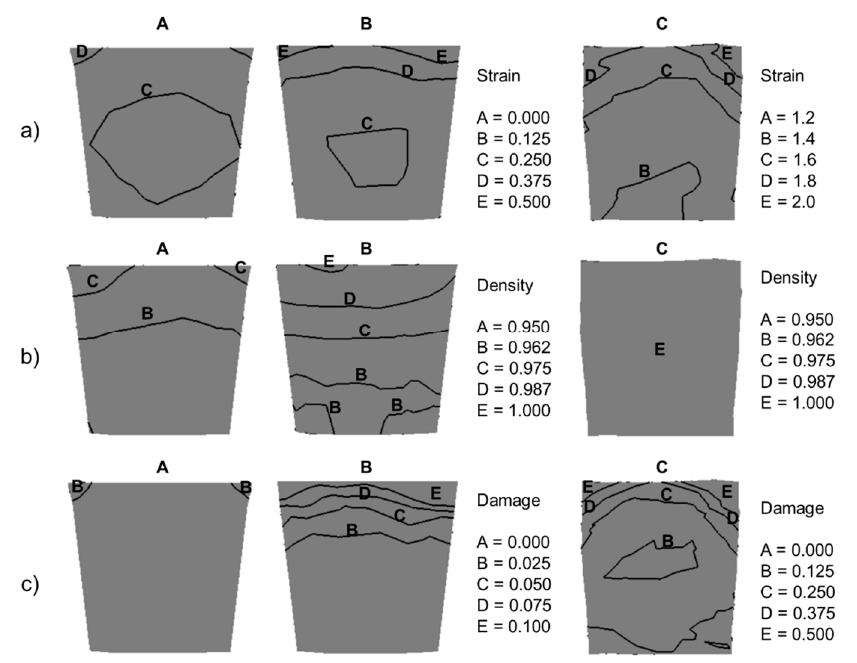
Figure 7. The distribution of: ( a ) effective strain; ( b ) density, and ( c ) damage factor in cross section of the billet in three zones during the ECAR process. The A, B, and C represent deformation zones: A—Shape Rolling, B—Upsetting, and C—SPD.